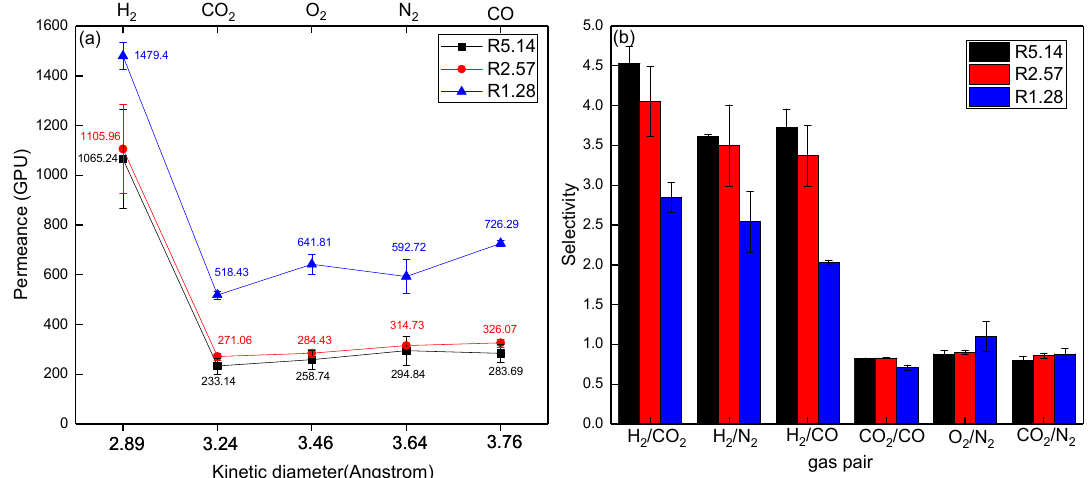
Figure 5. Effect of the flow rate ratio on ( a ) gas permeance and ( b ) selectivity of the obtained MMHFMs (used filler size: 1000 nm; air gap distance: 10 cm).